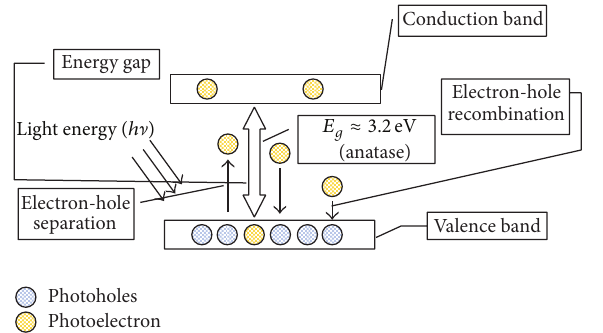
Figure 5: Simultaneous electron hole separation and recombination of titanium dioxide (anatase).